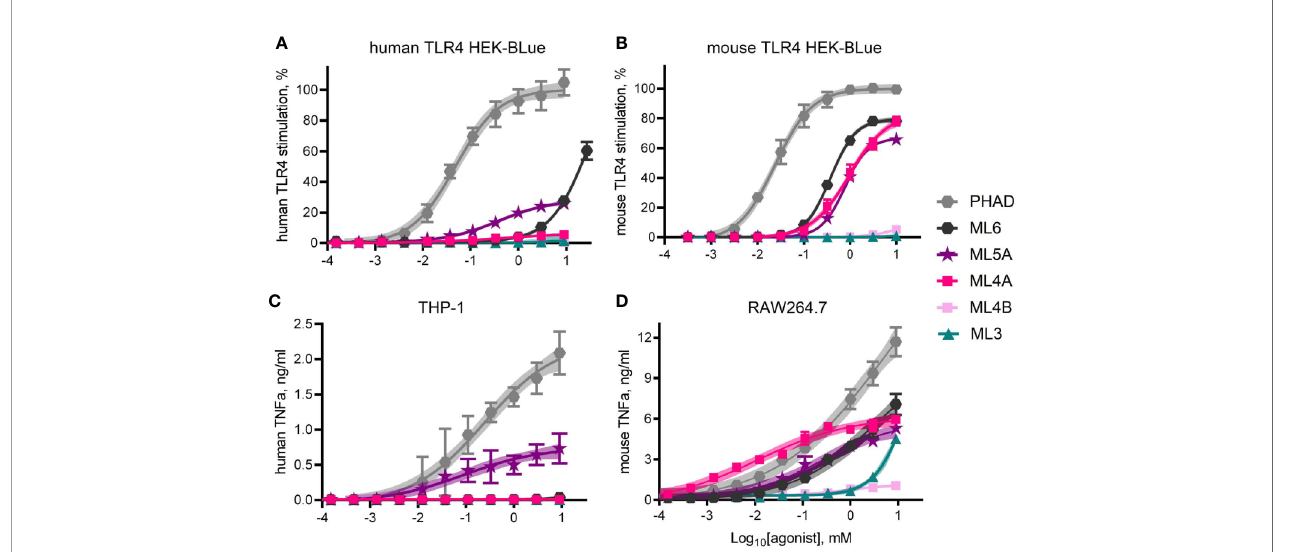
FIGURE 5 | TLR4 stimulatory activity of synthetic MPL adjuvant ® components. Synthetic versions of several of the major components of MPL adjuvant ® were tested for TLR4 stimulatory activity using HEK-Blue reporter cells that expressed either (A) human TLR4 or (B) mouse TLR4. Values shown are averages ± SD from three (A) or two (B) independent experiments normalized by setting 100% = top dose plateau of PHAD in each experiment. Shaded regions indicate 99% con fi dence intervals within which the true population means should occur 99% of the time. TNF a secretion by (C) human THP-1 and (D) mouse RAW264.7 cells as measured by ELISA 24 hrs after exposure to agonists in triplicate pooled from two or three independent experiments, respectively, with the exception of ML4A, ML4B and ML3 which were tested in triplicate in one experiment with RAW264.7 cells. Overall, ML5A and ML6 are weaker agonists of human TLR4 than of mouse TLR4, relative to the full agonist PHAD, whereas ML4A is an agonist only of mouse